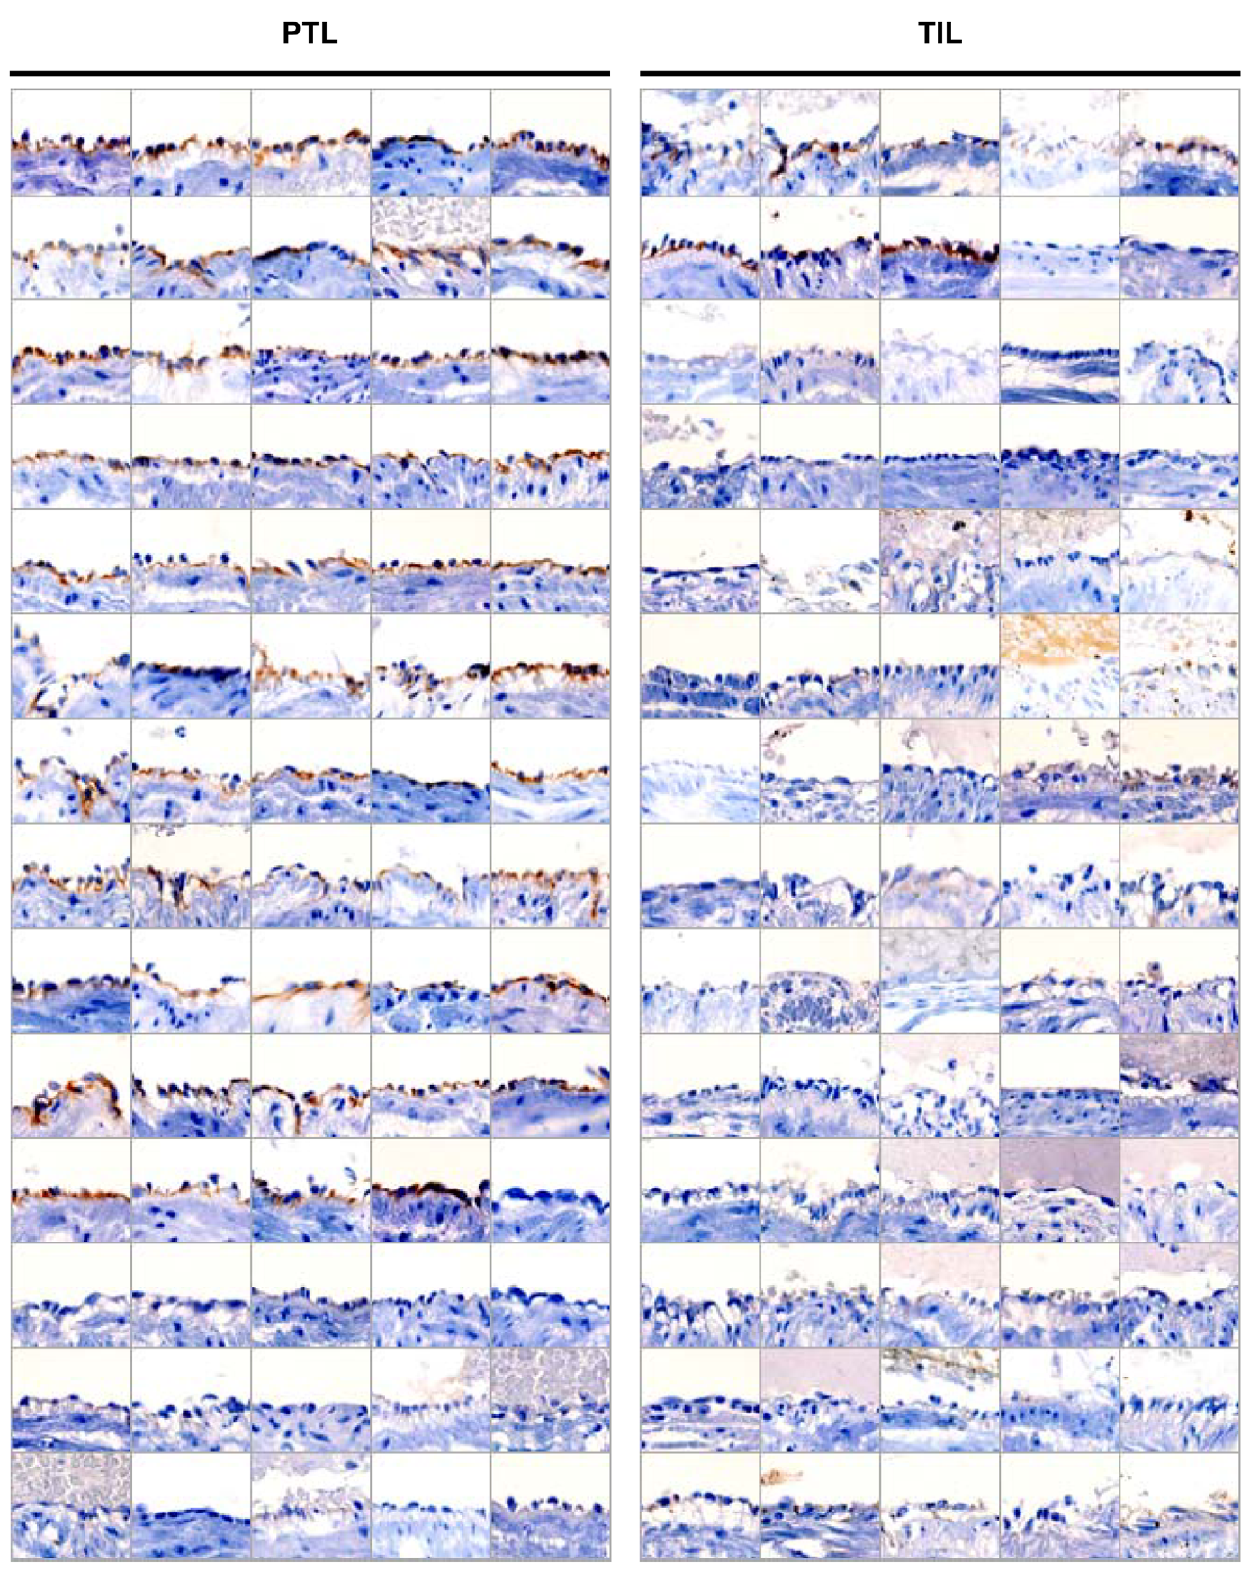
Figure 5. C4d deposition on fetal umbilical vein endothelium by immunohistochemistry. C4d immunoreactivity on fetal umbilical vein endothelium is found in 54 out of 70 cases with preterm labor and intact membranes followed by preterm birth. However, there are only eight C4d positive cases among 70 cases with normal term labor (77.1% vs. 11.4%; p , 0.001). PTL , preterm labor and intact membranes and preterm birth; TIL , term labor and normal term birth. doi:10.1371/journal.pone.0016806.g005 PLoS ONE |